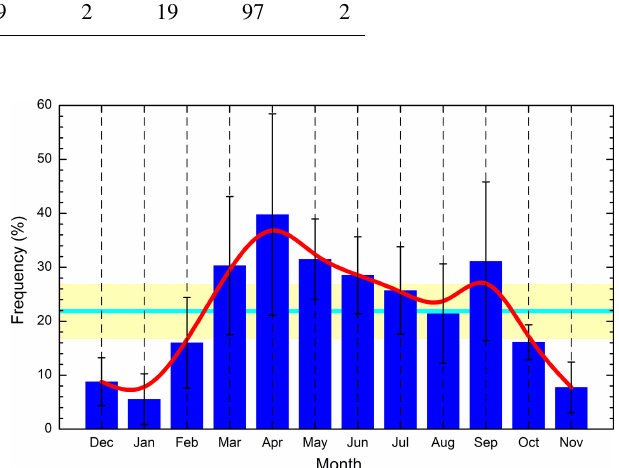
Figure 1. Monthly mean relative occurrence frequency of NPF and growth events for the joint 6-year-long data set. The error bars show ± 1 standard deviation, the horizontal line in cyan indicates the over- all annual mean frequency, the yellow bands represent ± 1 standard deviation of the annual mean, and the smooth curve in red serves to guide the